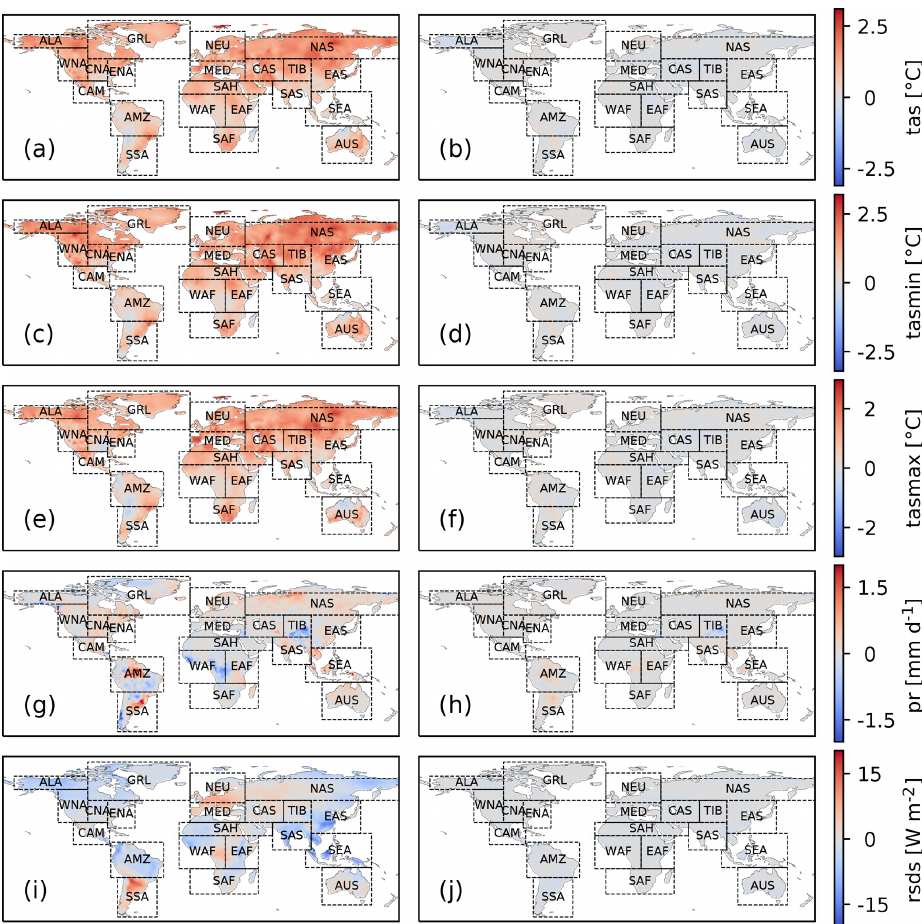
Figure 5. Differences between multi-year averages over the late (1990–2019) and early (1901–1930) time period for the factual (left) and counterfactual (right) GSWP3-W5E5 dataset. Results are shown for tas, tasmin, tasmax, pr and rsds (from top to bottom). Rectangles show the 21 world regions from Giorgi and Francisco (2000). Note that the color scale is capped for precipitation; i.e., values below − 2mmd − 1 and above 2mmd − 1 are displayed in dark blue and dark red,